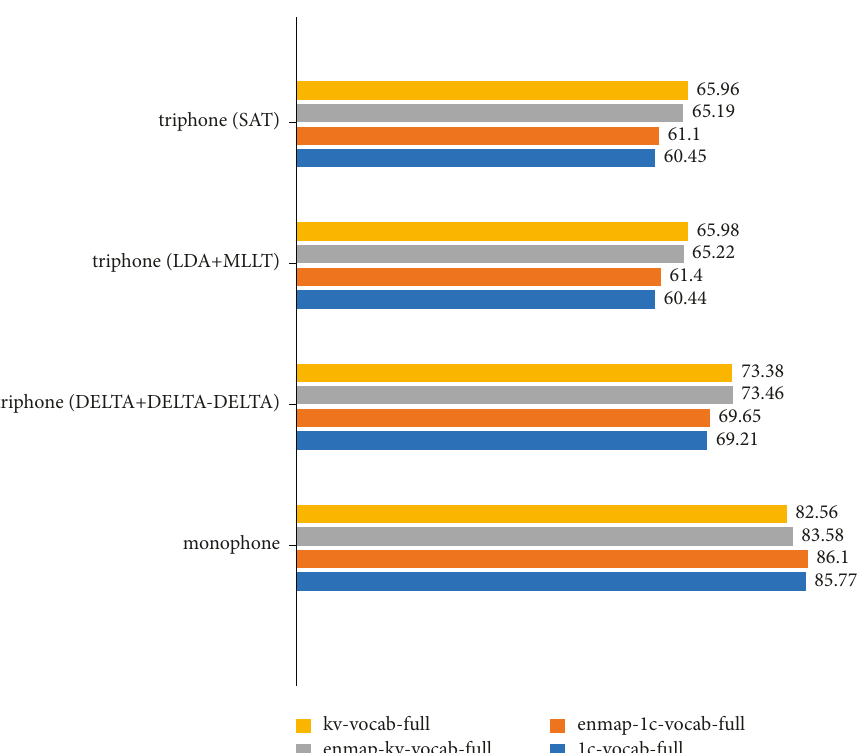
Figure 11: The %WER comparison for different GMM-HMM models using 46,550 unvalidated utterances.